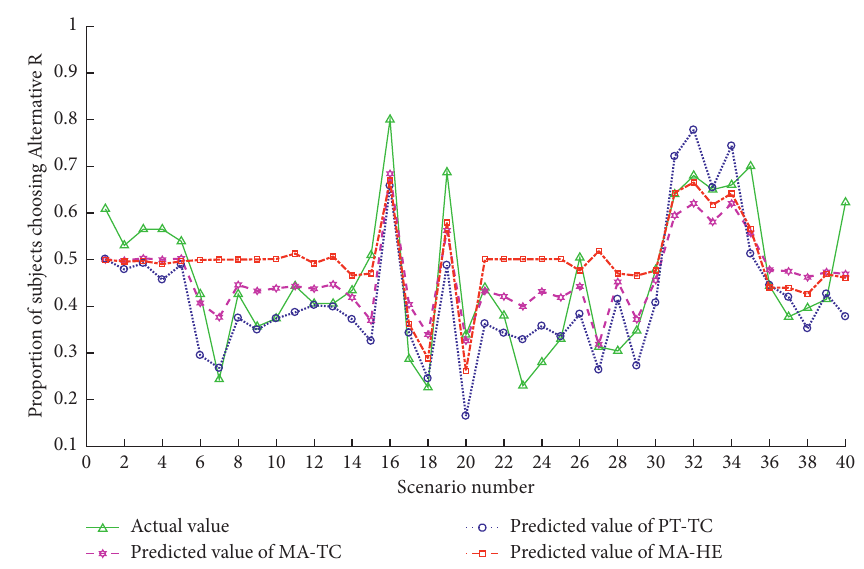
Figure 7: Forecast curve under risky